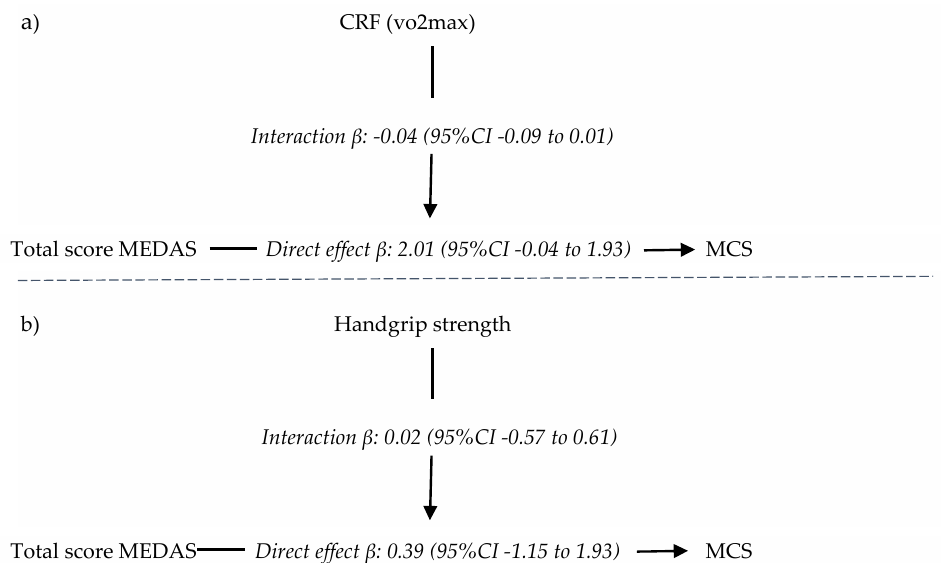
Figure A1. ( a ) CRF VO2 max estimate and ( b ) handgrip strength moderation models of the relationship between the total MEDAS score and mental HRQoL (MCS). Adjusted by age, sex, and SES. Beta expressed as unstandardized regression coefficients and 95% confidence interval.